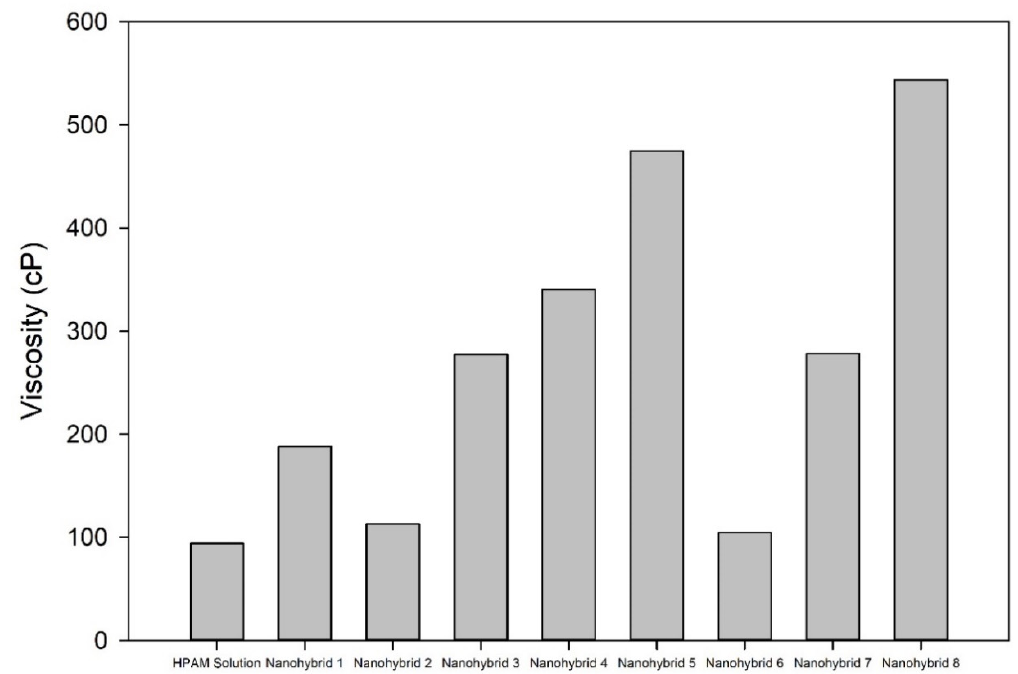
Figure 4. Apparent viscosity of HPAM solution and nanohybrid systems as per Table 1. Shear rate = 10 s − 1 , T = 85 °C.